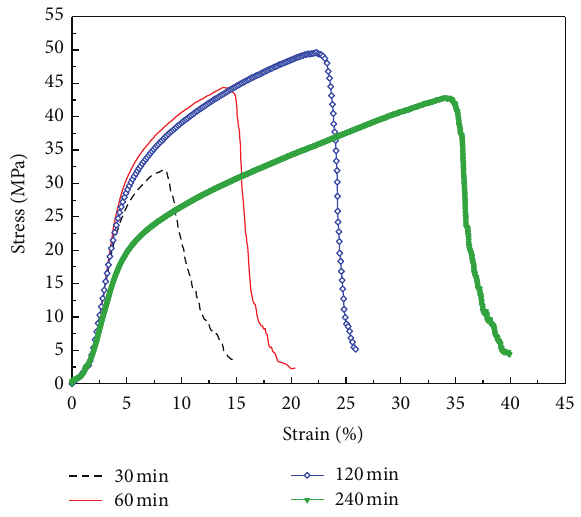
Figure7:Tensilestress-straincurvesoftheSSSFFwith75%porosity sintered at 1200 ∘ C.